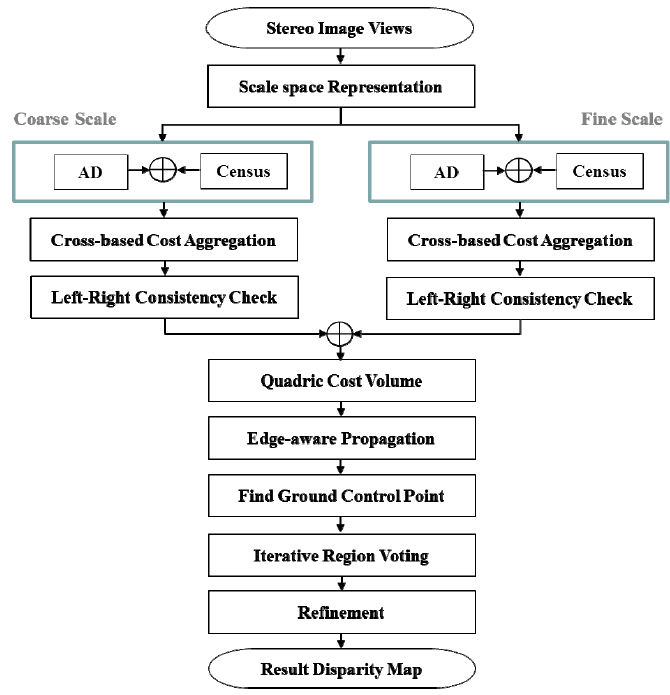
Figure 1. Proposed block diagram.